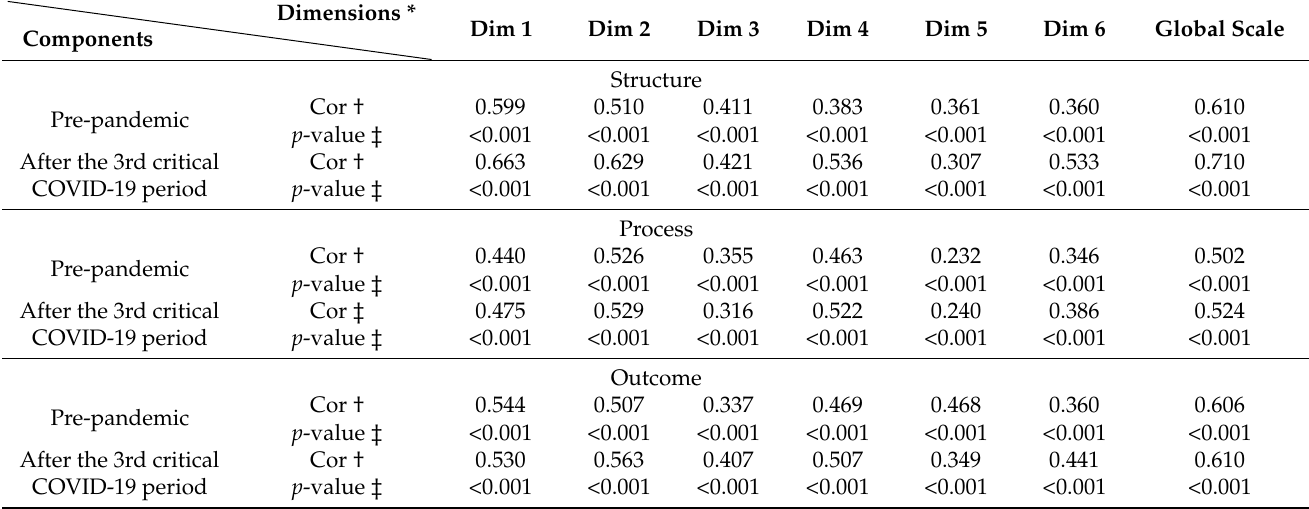
Table 3. Correlation between components of professional practice environments and nurses’ job